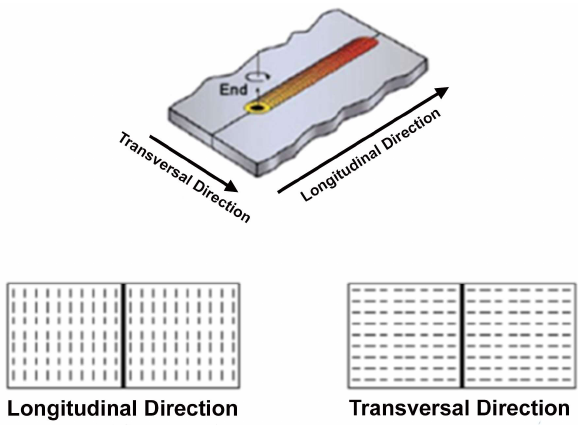
Figure 1. Relation between the rolling and the welding directions.